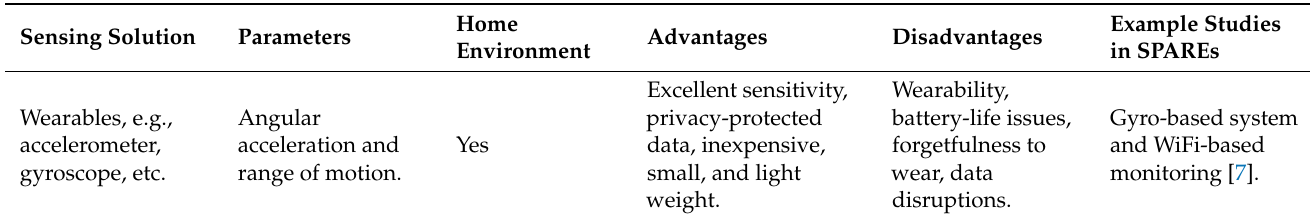
Table 1. Comparison of Sensing Solutions (SSs) in Sprained Ankle Rehabilitation Exercises (SPAREs) monitoring. Home Sensing Solution Parameters Advantages Disadvantages Environment Wearables, e.g., Angular accelerometer, acceleration gyroscope, etc.